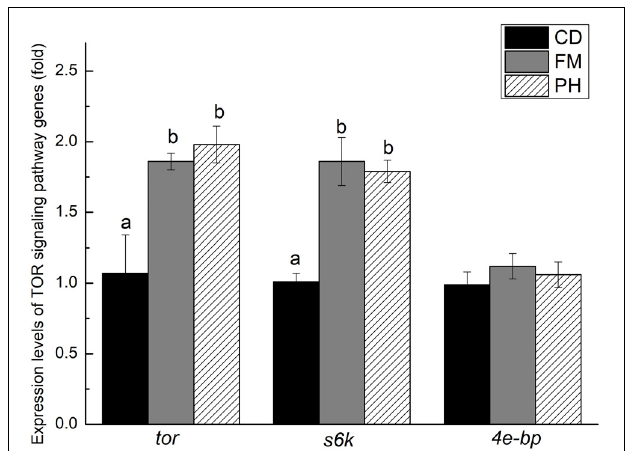
TABLE 7 | Muscle composition of shrimps fed with different experimental diets for 6 weeks.